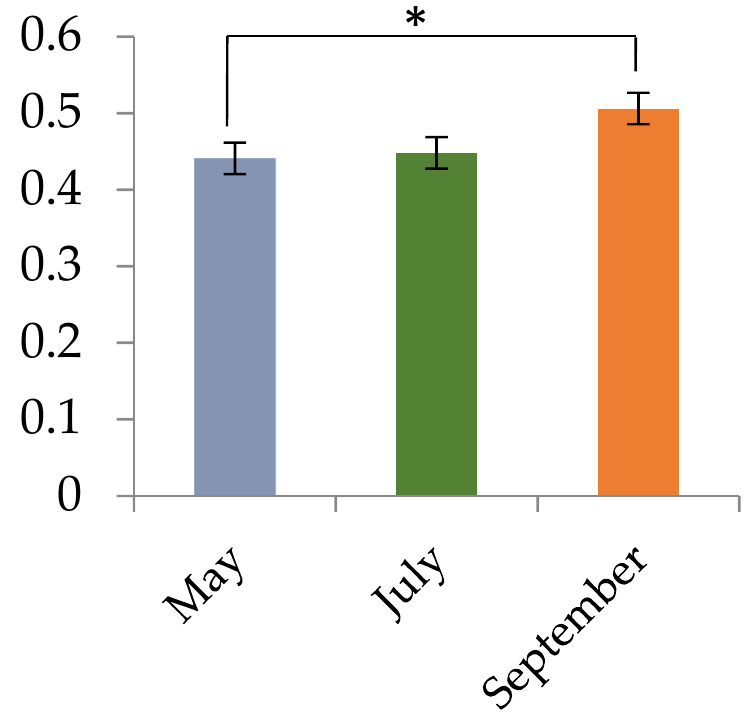
Figure 2. Absorbance of Gleditsia sinensis pod extract in May, July, and September. Note: The ordinate represents absorbance after colorimetry of the pod extract at three stages. (*): p -value ≤ 0.05, significant